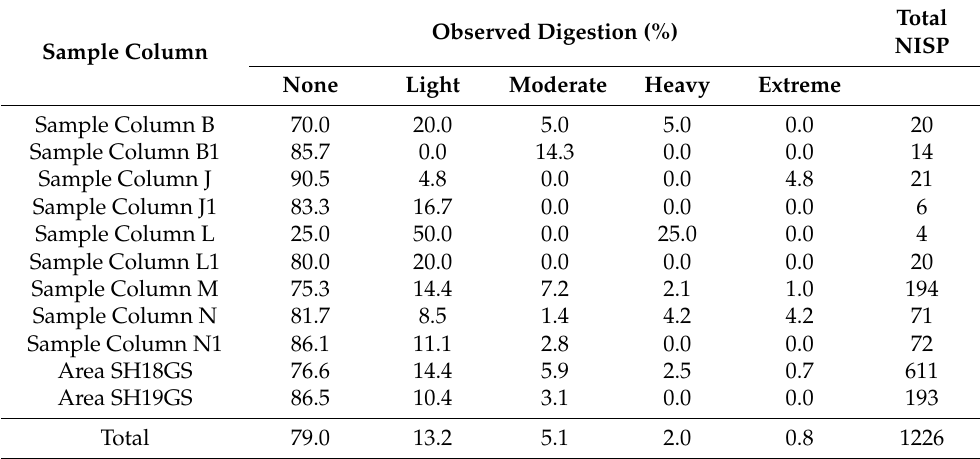
Table 7. Overall isolated arvicoline molar digestion intensities observed in each area or sample column. The observed digestion is presented as a proportion of each sample column or